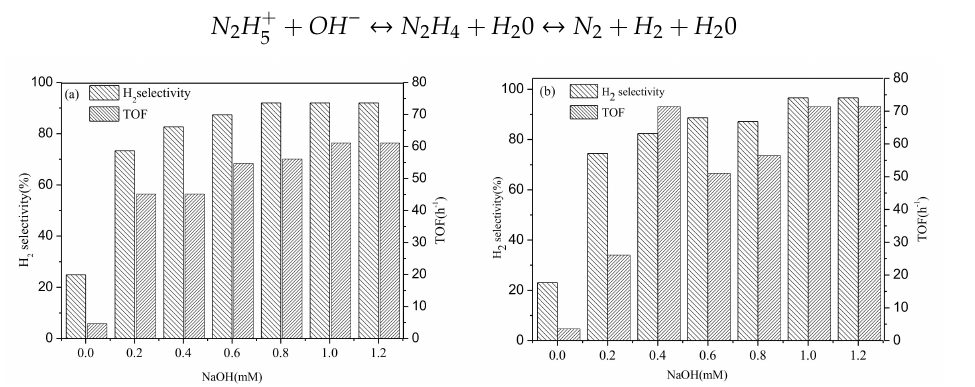
Figure 5. Influence of NaOH concentration on H 2 selectivity and reaction rate of the catalysts ( a ) Ni 9 Mo 1 (Pr 2 O 3 ) 0.375 and ( b ) Ni 4 Mo@Cu 2 O.